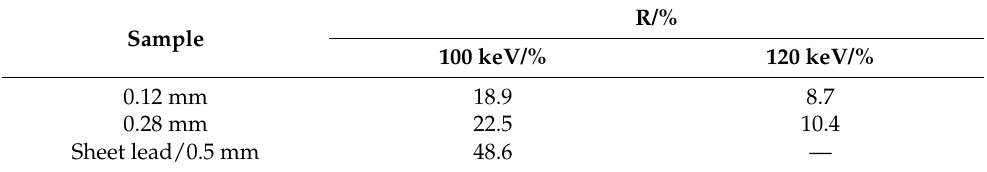
Table 4. Shielding ratio of basalt fibers on gamma rays with different energies.